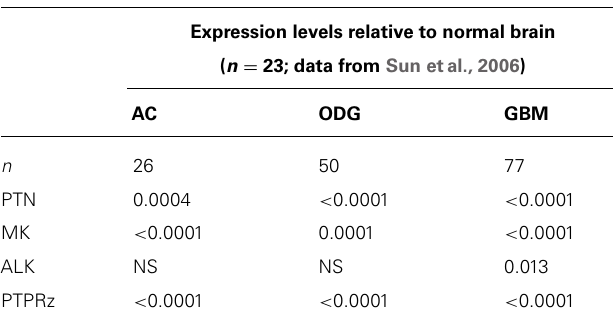
Table 1 | Brain tumor gene expression. Expression levels relative to normal brain